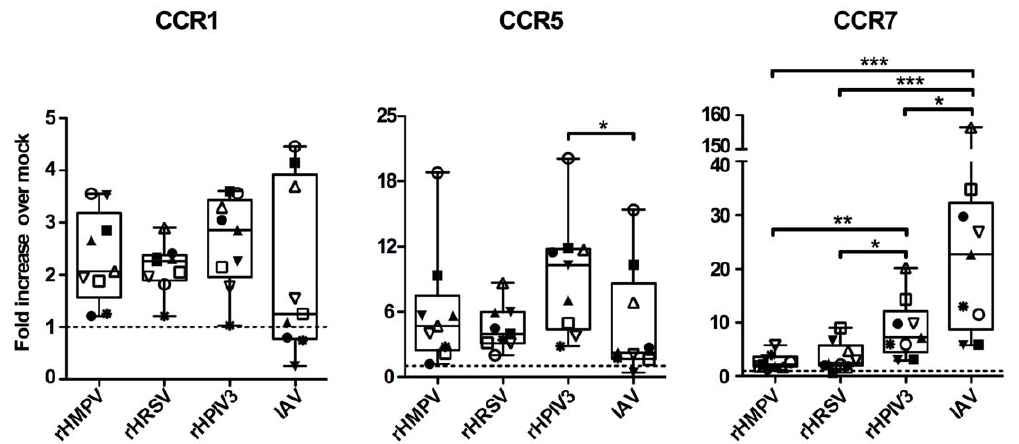
Figure 1. CCR1, 5 and 7 gene expression of MDDC stimulated with rHMPV, rHRSV, rHPIV3, or IAV. Immature MDDC (n=9 donors) were infected with rHMPV, rHRSV, rHPIV3, or influenza/A/Udorn (IAV). Twenty-four h post infection, total cellular RNA was prepared and reverse-transcribed using random primers, and the cDNA analyzed in triplicate by qPCR using TaqMan PCR assays. qPCR results were analyzed using the comparative threshold cycle ( DD C T ) method, normalized to 18S rRNA. The results are expressed as fold-increase over mock. Statistical differences are indicated by asterisks (* P # 0.05, ** P # 0.01, *** P # 0.001, Materials and Methods).